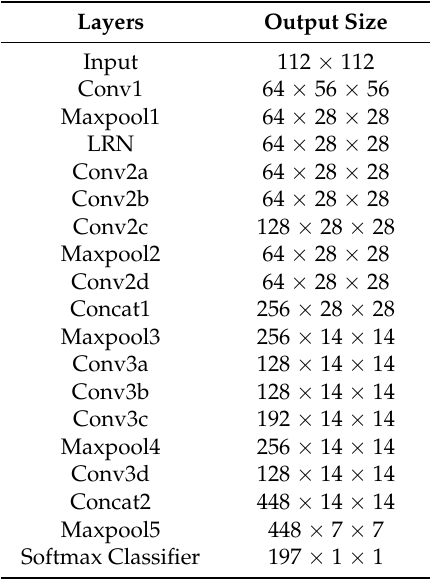
Table 1. Layers and output